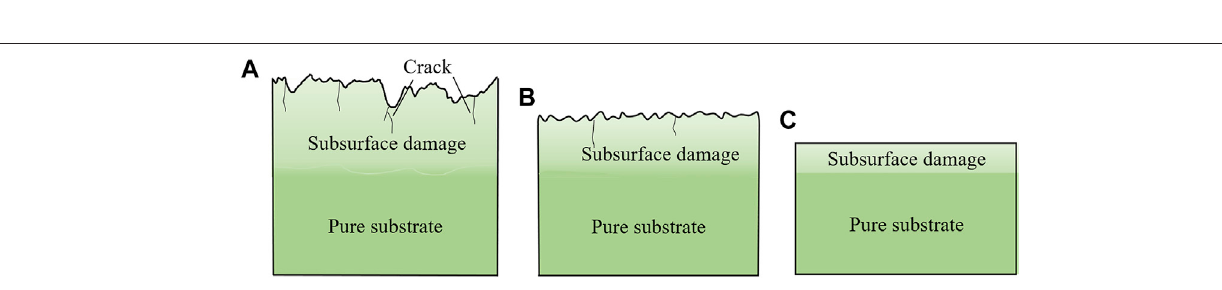
FIGURE 3 | Schematic diagrams of (A) rough grinding, (B) fi ne grinding, and (C) CMP surface/subsurface cross-section of 4H-SiC